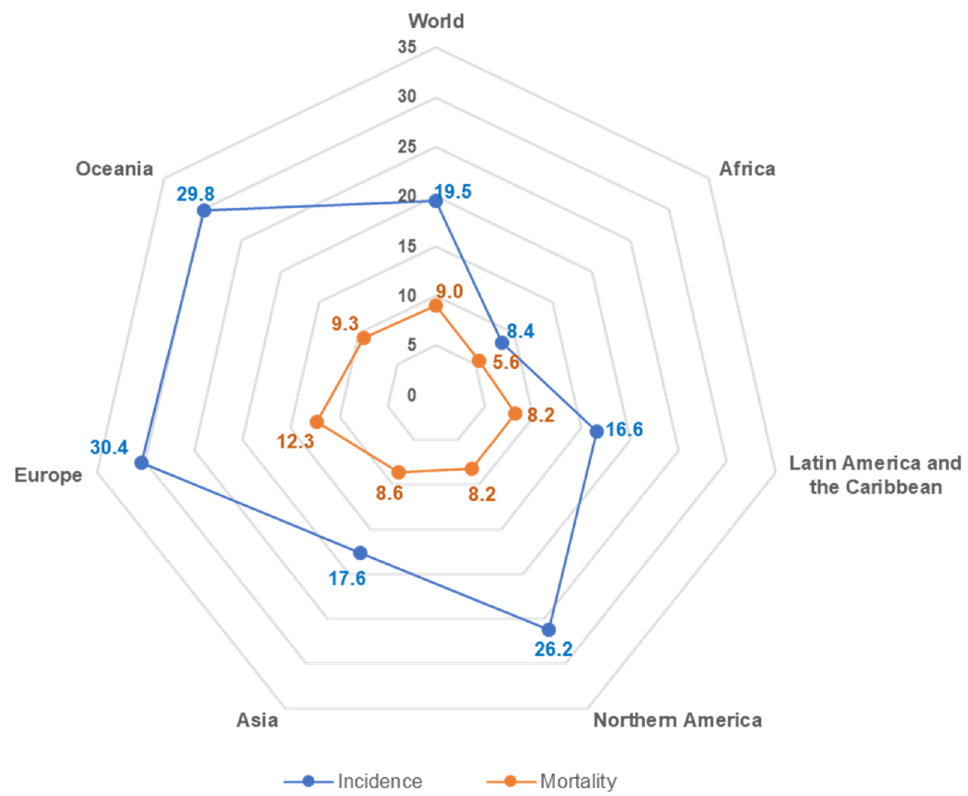
Figure 1. Standardized incidence and mortality rates for CRC for both sexes in 2020, per 100,000.